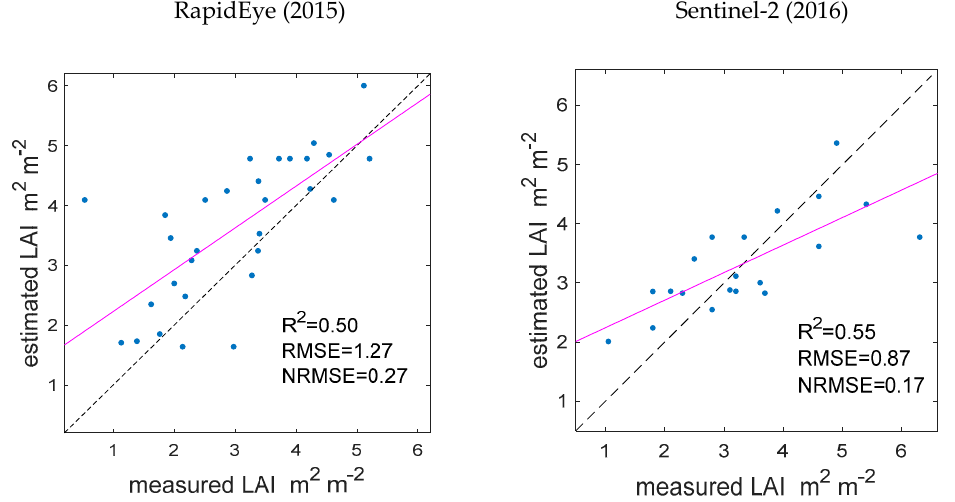
Figure 6. The average absolute errors (AAEs) calculated between RapidEye and Sentinel-2 measured reflectance and their corresponding best-fit reflectance from LUTs. The AAE has been calculated from RapidEye (n = 30) and Sentinel-2 (n = 20) reflectance and their corresponding best fit reflectance from the LUTs, respectively. The AAE units are reflectance.